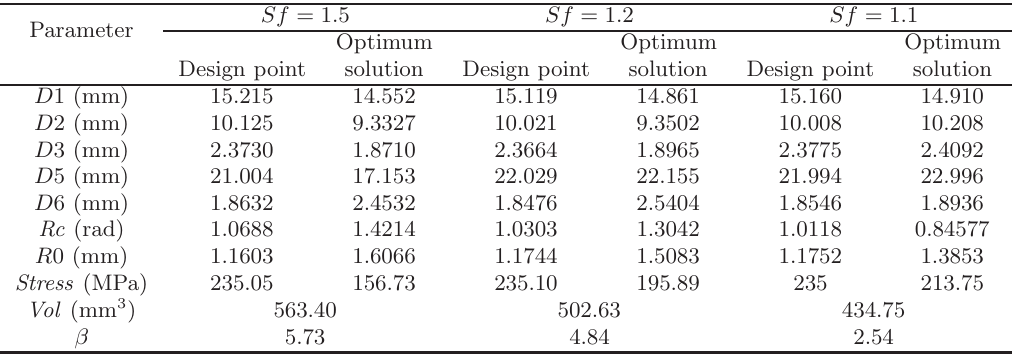
Table 2. Results of DDO procedure for different values of safety factors.